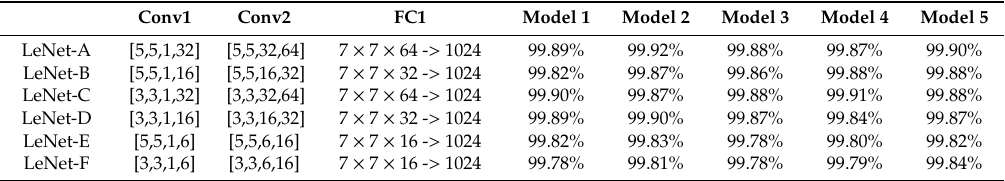
Figure 10. Architecture of LeNet with different convolution kernels: ( a ) LeNet-A; ( b ) LeNet-B; ( c ) LeNet-C; ( d ) LeNet-D; ( e ) LeNet-E; ( f ) LeNet-F. Table 4. Test accuracy of six LeNet